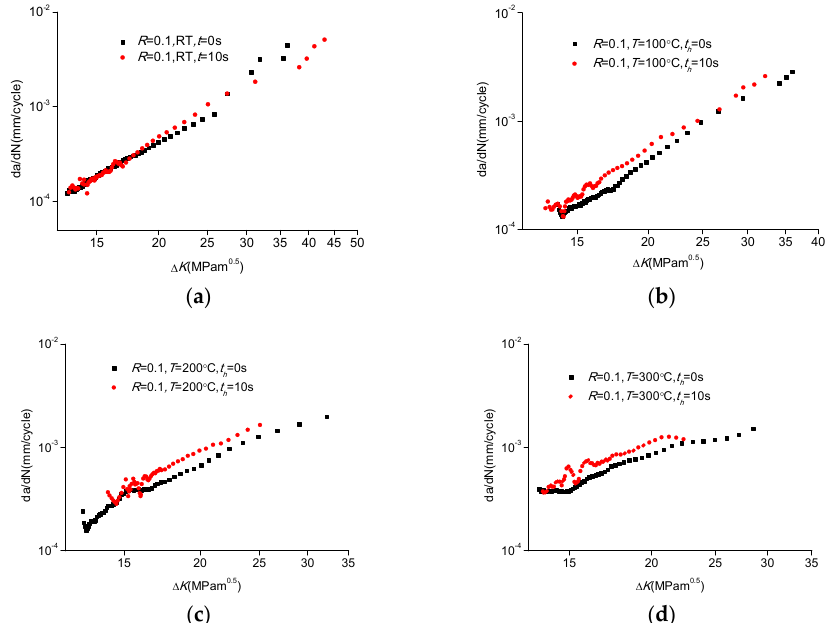
Figure 11. The effect of dwell time on CP-Ti FCG at different temperatures under low load ratio: ( a ) RT; ( b ) 100 ◦ C; ( c ) 200 ◦ C; ( d ) 300 ◦